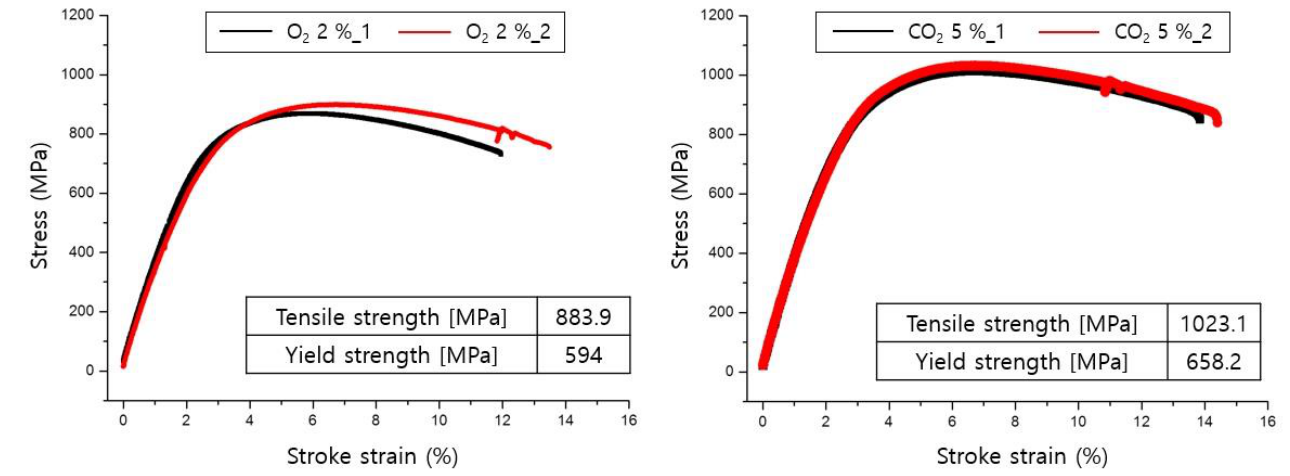
Figure 5. Tensile test results in HHA1 butt joint with O 2 and CO 2 gas.